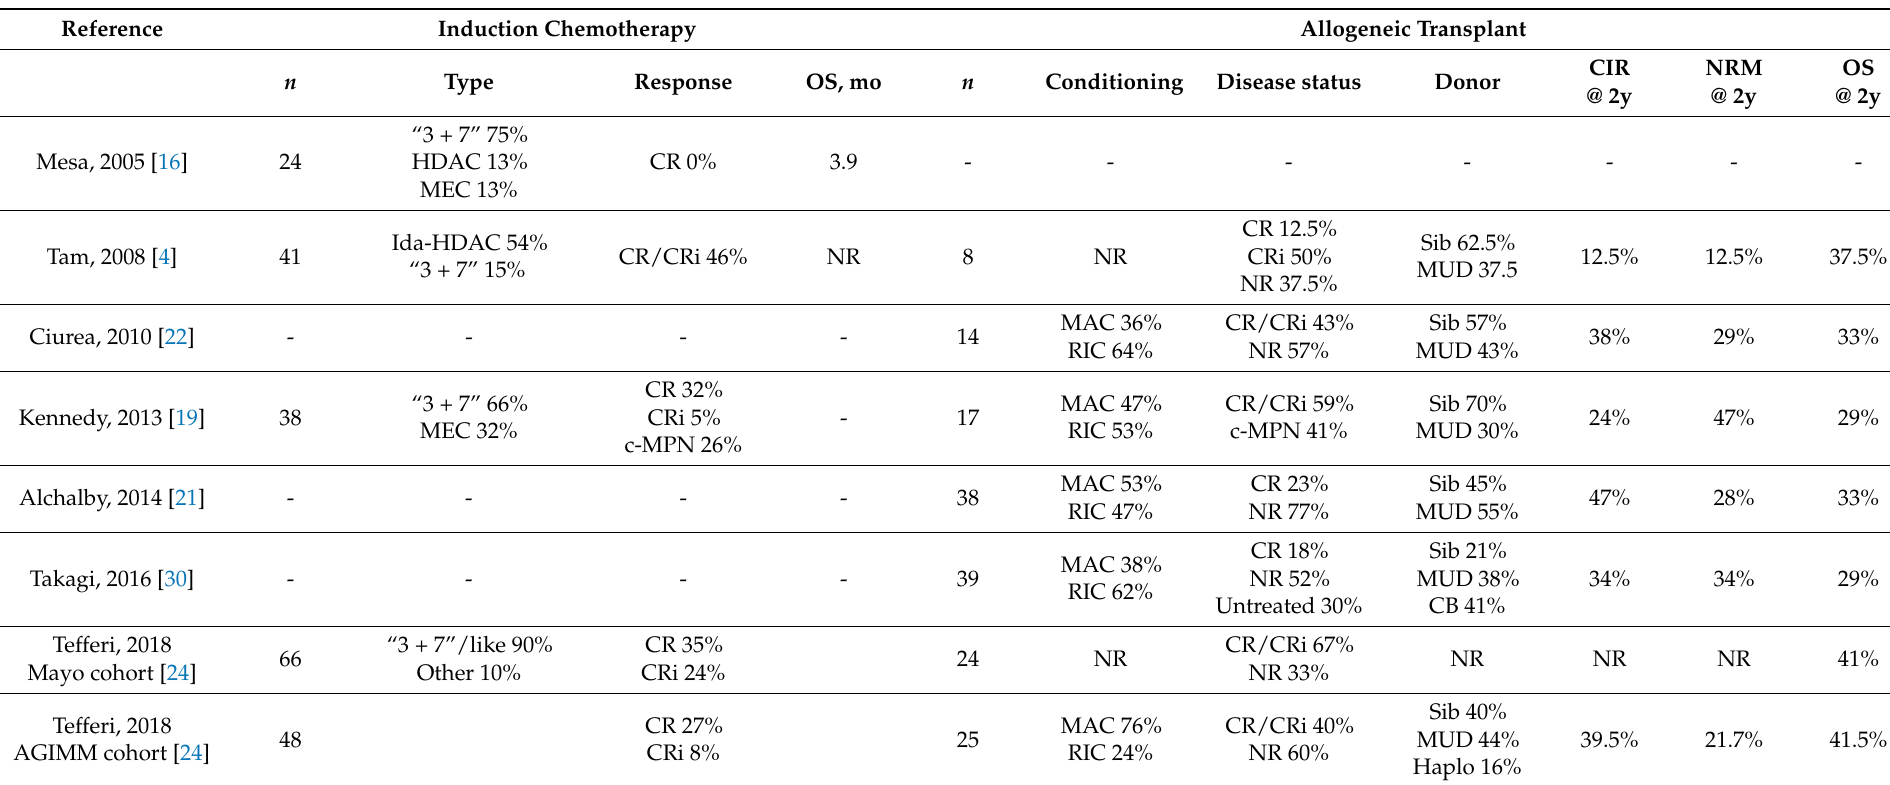
Table 2. Summary of reports about intensive therapeutic approaches (including allogeneic hematopoietic stem cell transplant (HSCT)) in secondary acute myeloid leukemia